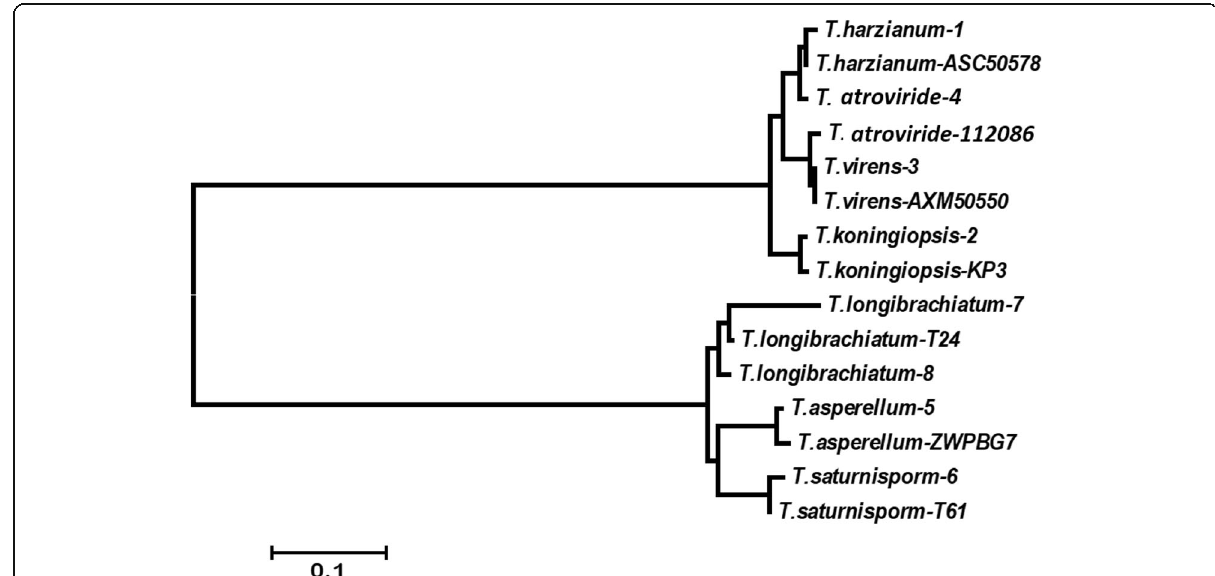
Fig. 2 Phylogenetic tree of the eight Trichoderma strains. The tree was built using the nucleotide sequences of the ITS region among the eight strains of the Trichoderma genus used in this study versus other Trichoderma strains deposited in the GenBank